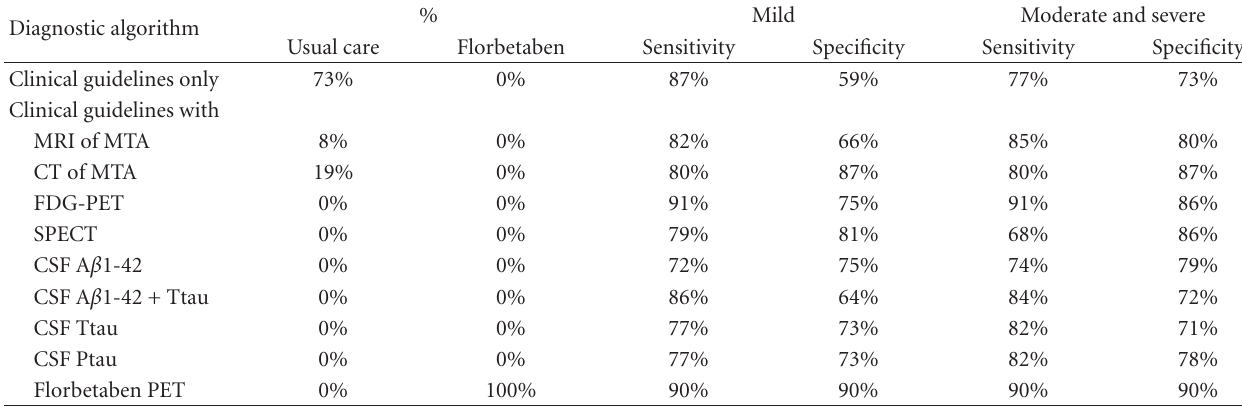
Table 1: Distribution of diagnostic algorithms and corresponding accuracy by severity (based on MMSE). Diagnostic algorithm Clinical guidelines